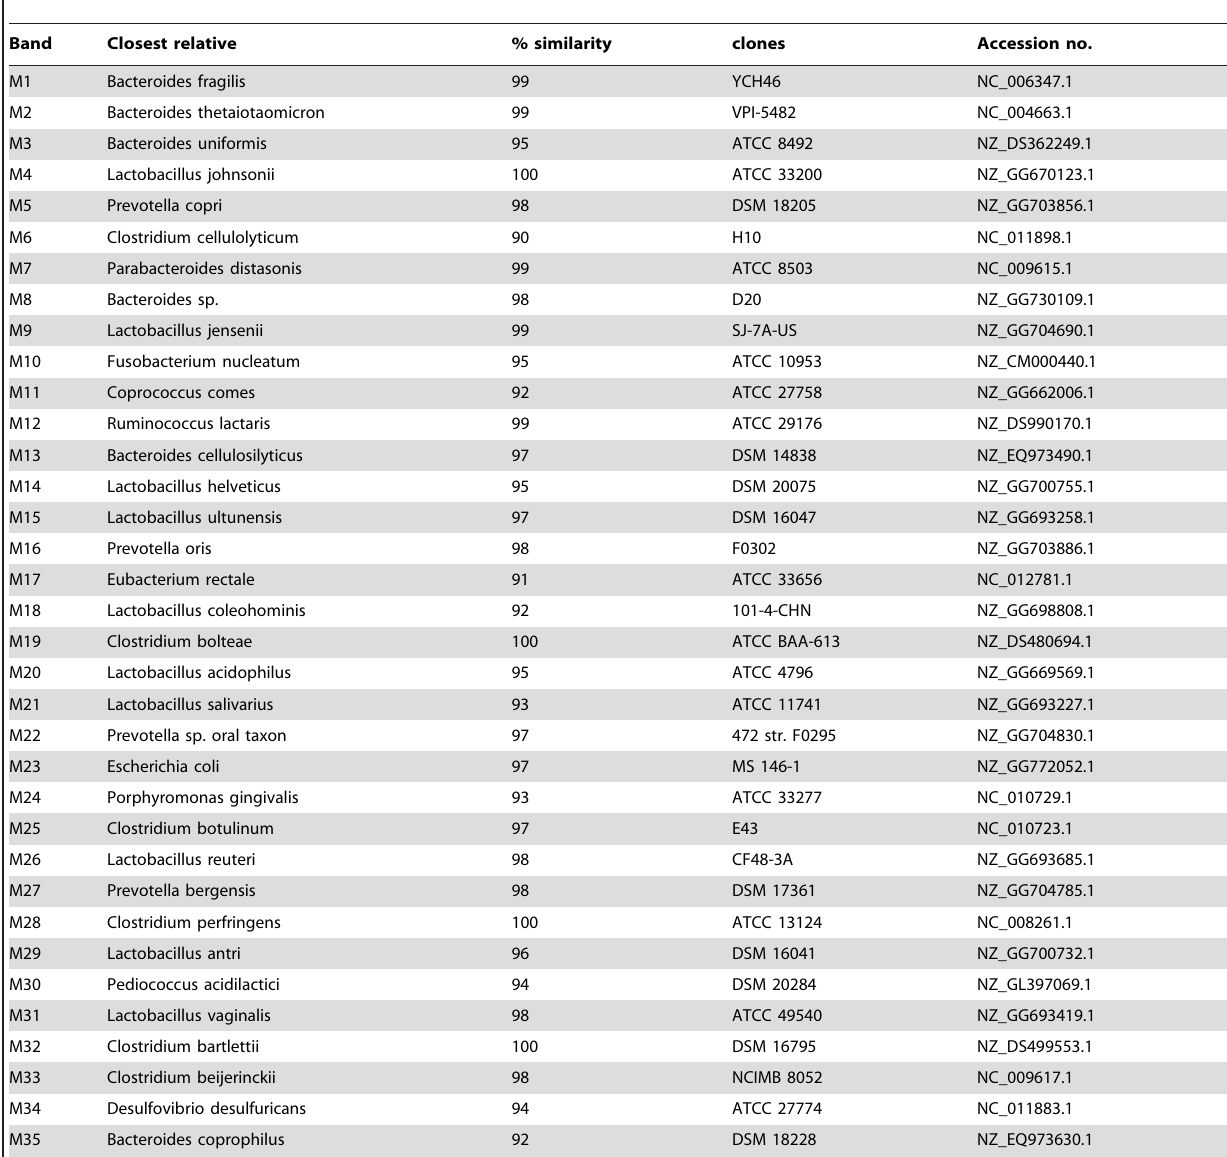
Table 2. Similarities of 16S rDNA gene sequences of mucosal-related microbiota with closest match sequences retrieved.